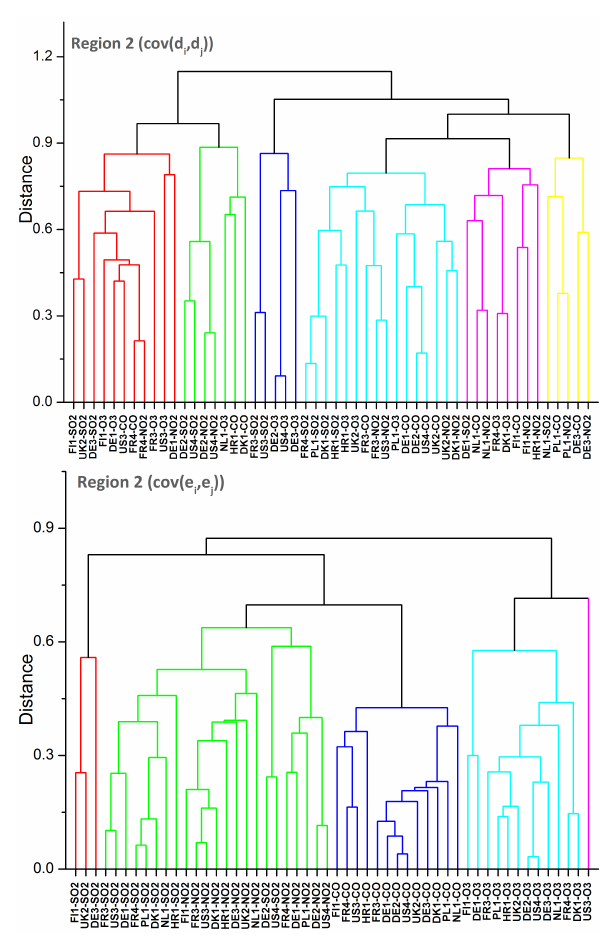
Fig. 2. Associativity trees for all models and species (European re- gion 2) using (a) the cov( d i , d j ) and (b) the cov( e i , e j ) as distance